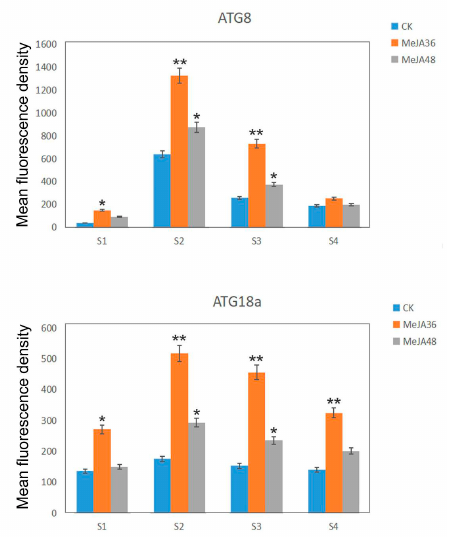
Figure 8. Quantifications of the mean fluorescence density of colocalization of ATG8 and ATG18a with MDC in laticifers of Euphorbia kansui at each development stage from S1 to S4. The bar diagram refers to the mean fluorescence density of the ATG8 and ATG18a associated autophagy structures. More than 150 laticifer cells for each stage were used for the quantification. Values represent the mean ± SE from three independent experiments. “*” and “**” indicate statistically significant ( p -value ≤ 0.05 or p -value ≤ 0.01 versus control groups), measured by the Student t test.